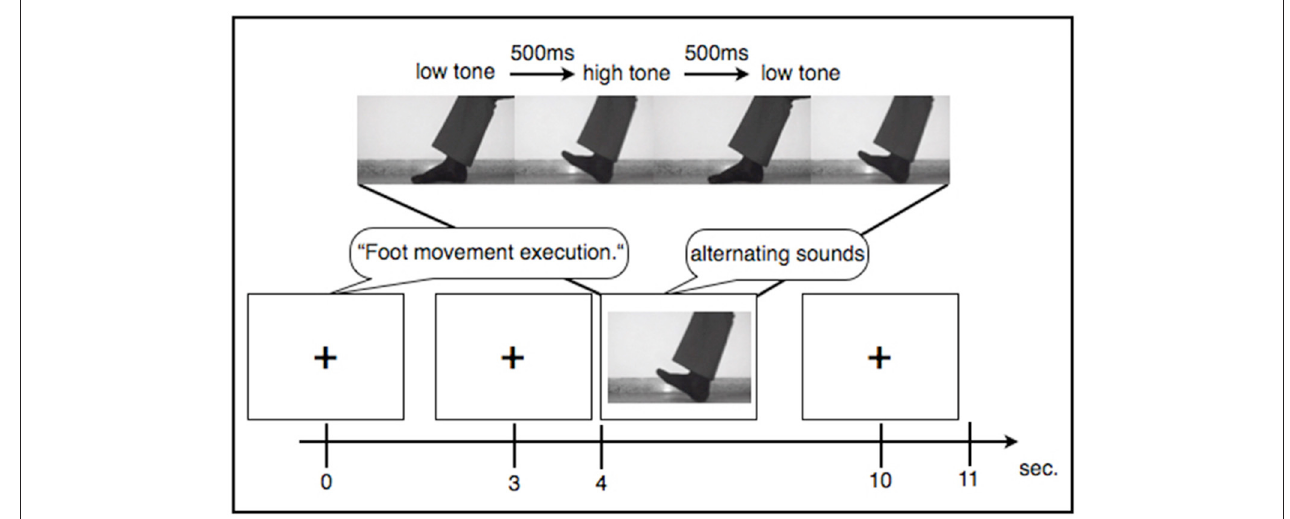
FIGURE 1 | Example sequence of an experimental trial.